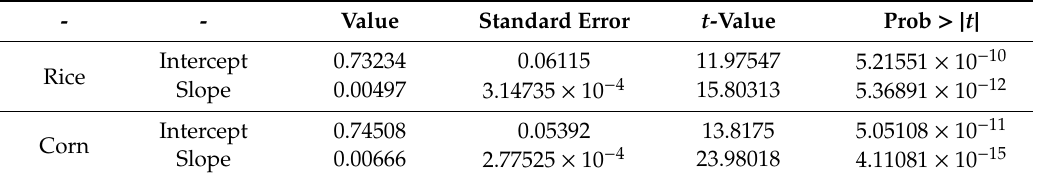
Table 5. Test results of the significance of the power consumption linear regression equation.